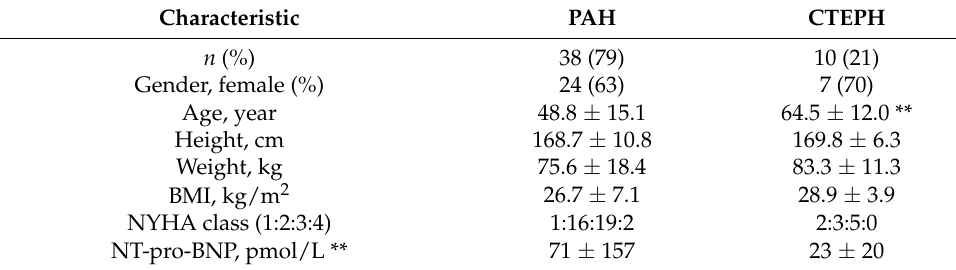
Table 2. Characteristics of patients in the treated